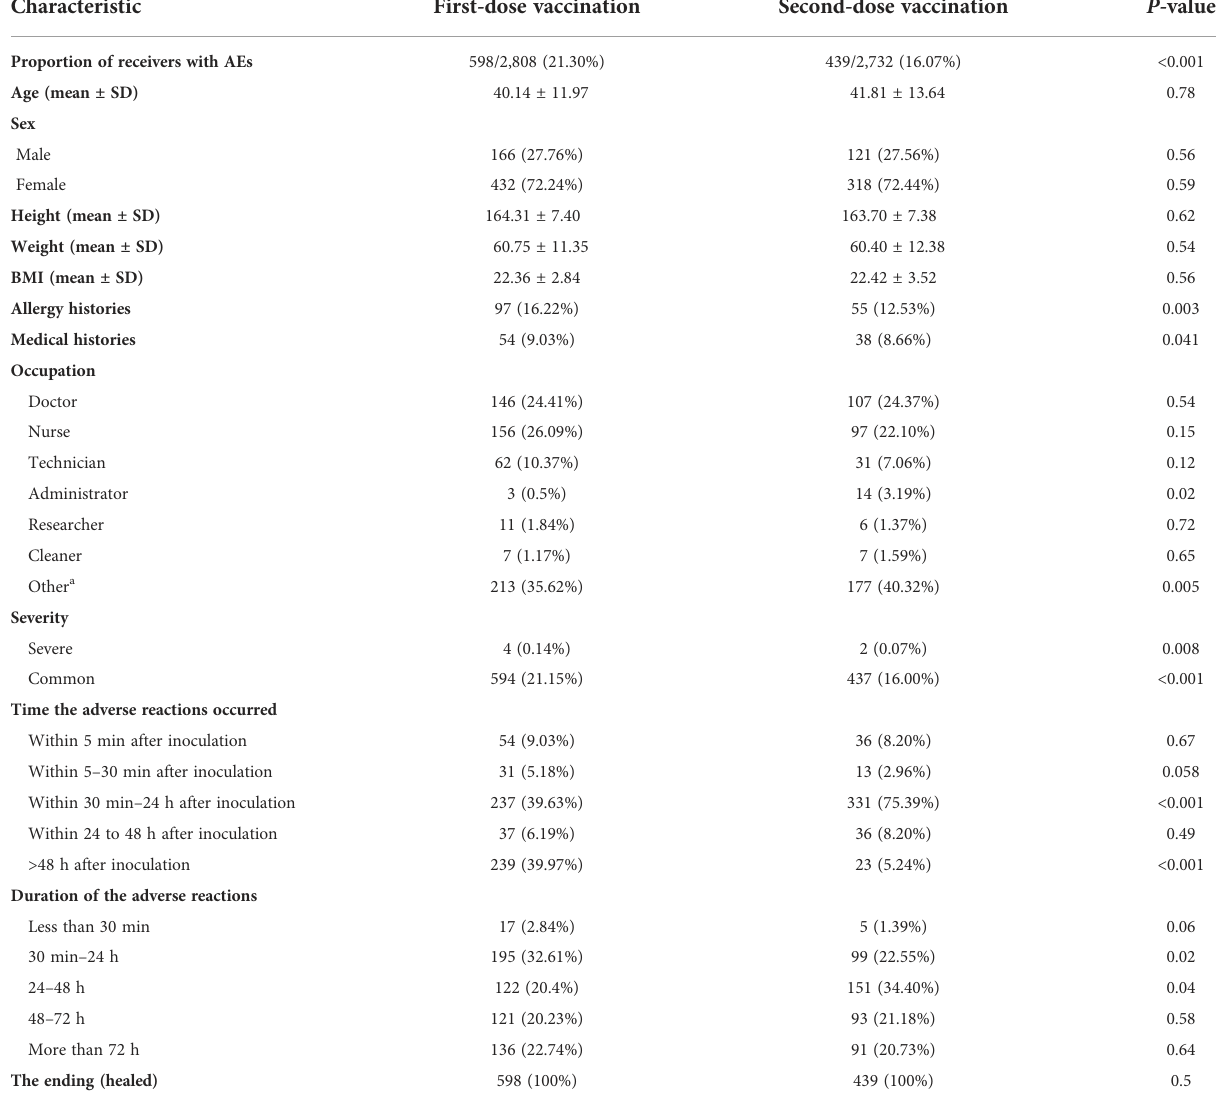
TABLE 1 Baseline characteristics of the registry population with AEs. Characteristic First-dose